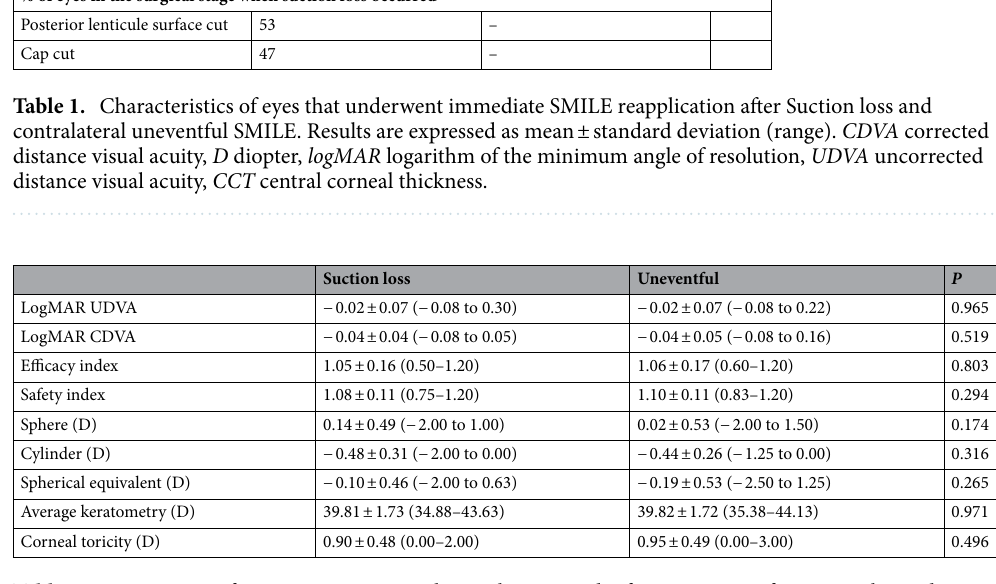
Table 2. Comparison of postoperative 6-month visual acuity and refractive errors of patients who underwent immediate SMILE reapplication after suction loss and contralateral uneventful SMILE. Results are expressed as mean ± standard deviation (range). logMAR logarithm of the minimum angle of resolution, UDVA uncorrected distance visual acuity, CDVA corrected distance visual acuity, D diopter.